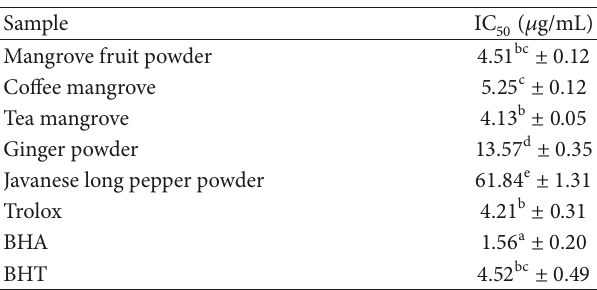
Table 3: Antioxidant activity of samples.